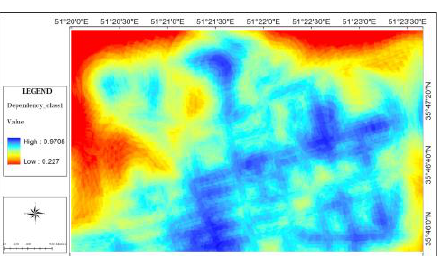
Figure 3: Distance to military bases for group 1